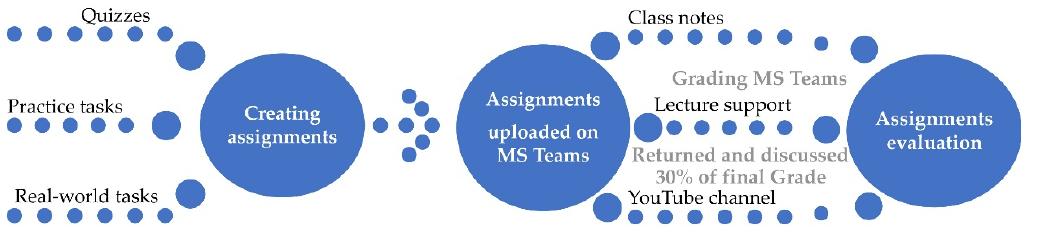
Figure 1. Scheme of the tasks’ assignment procedure.